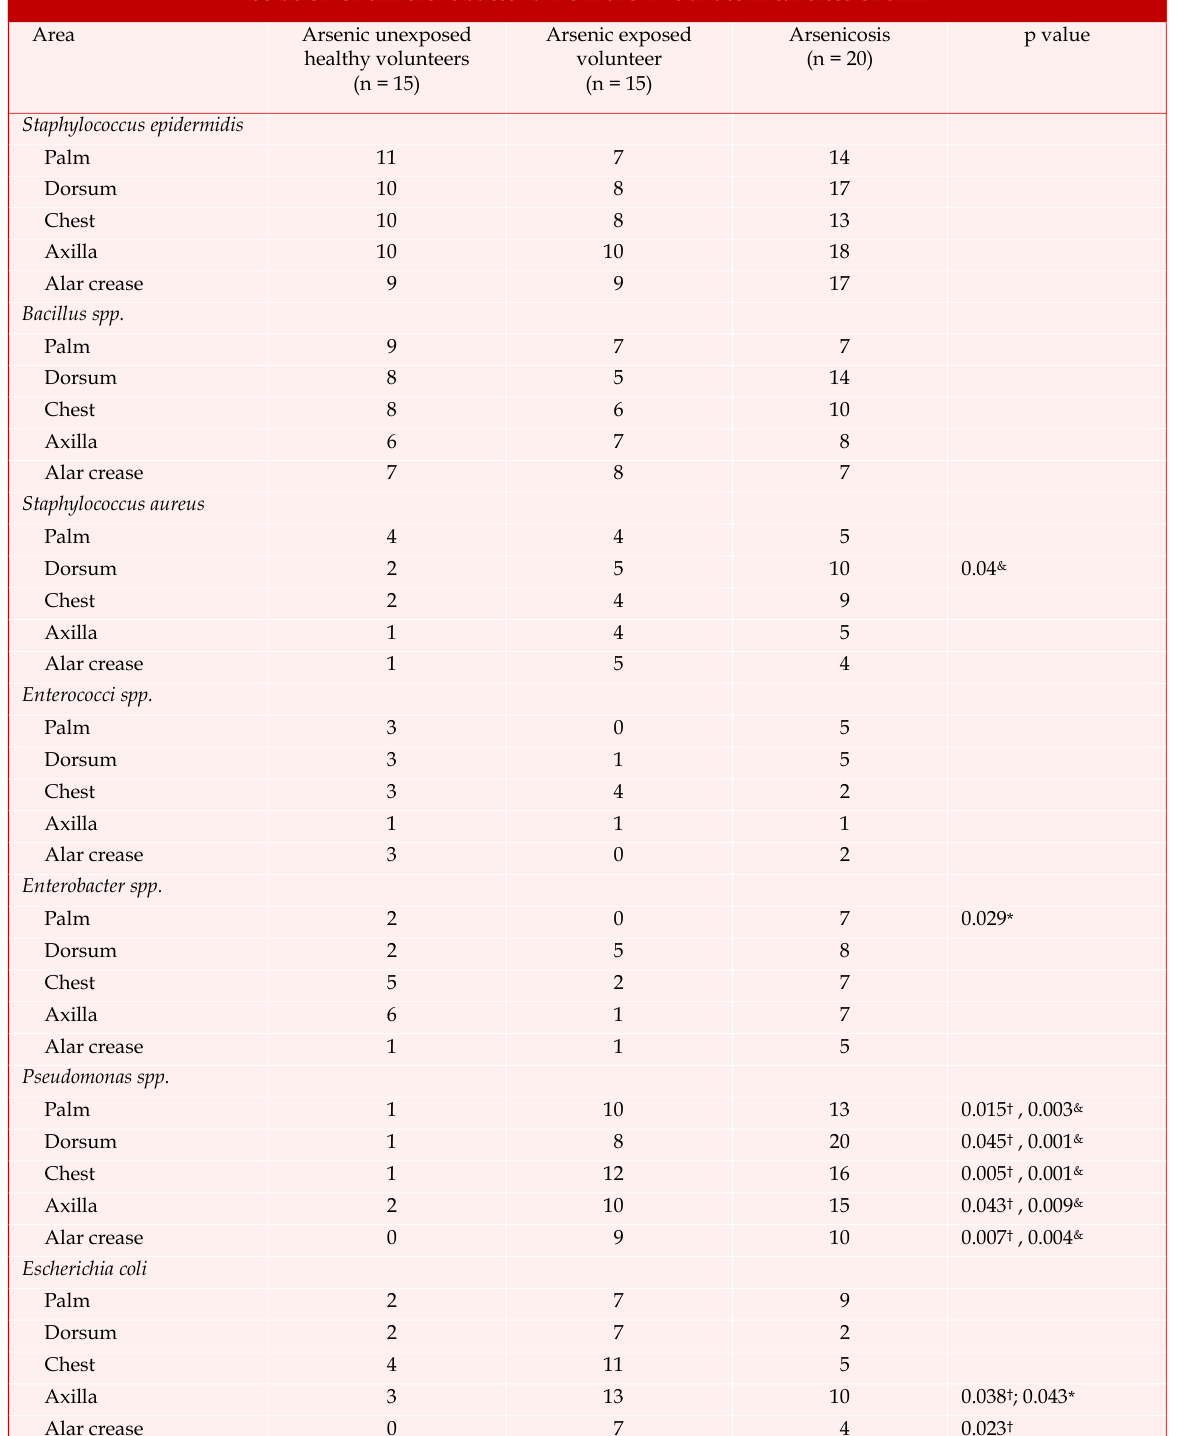
Isolation of different bacteria from the five anatomical sites of